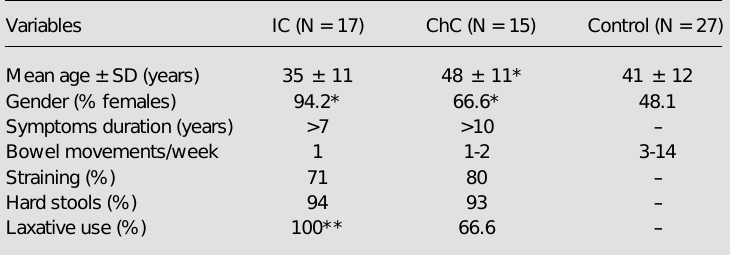
Table 1 - Clinical features of the study population.